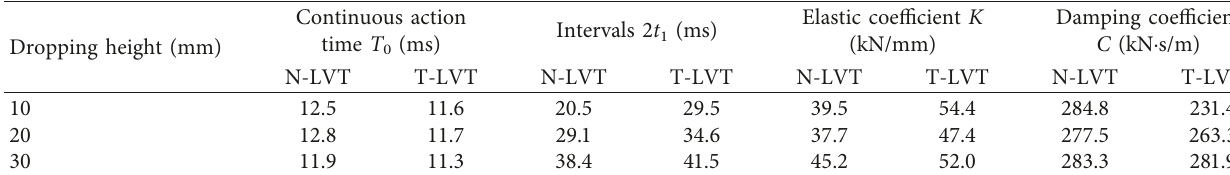
Table 1: Elastic coefficient and damping coefficient for the N-LVT and T-LVT. Dropping height